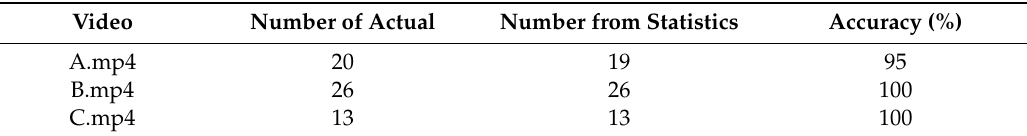
Table 6. YOLO-UA video traffic monitoring statistics.